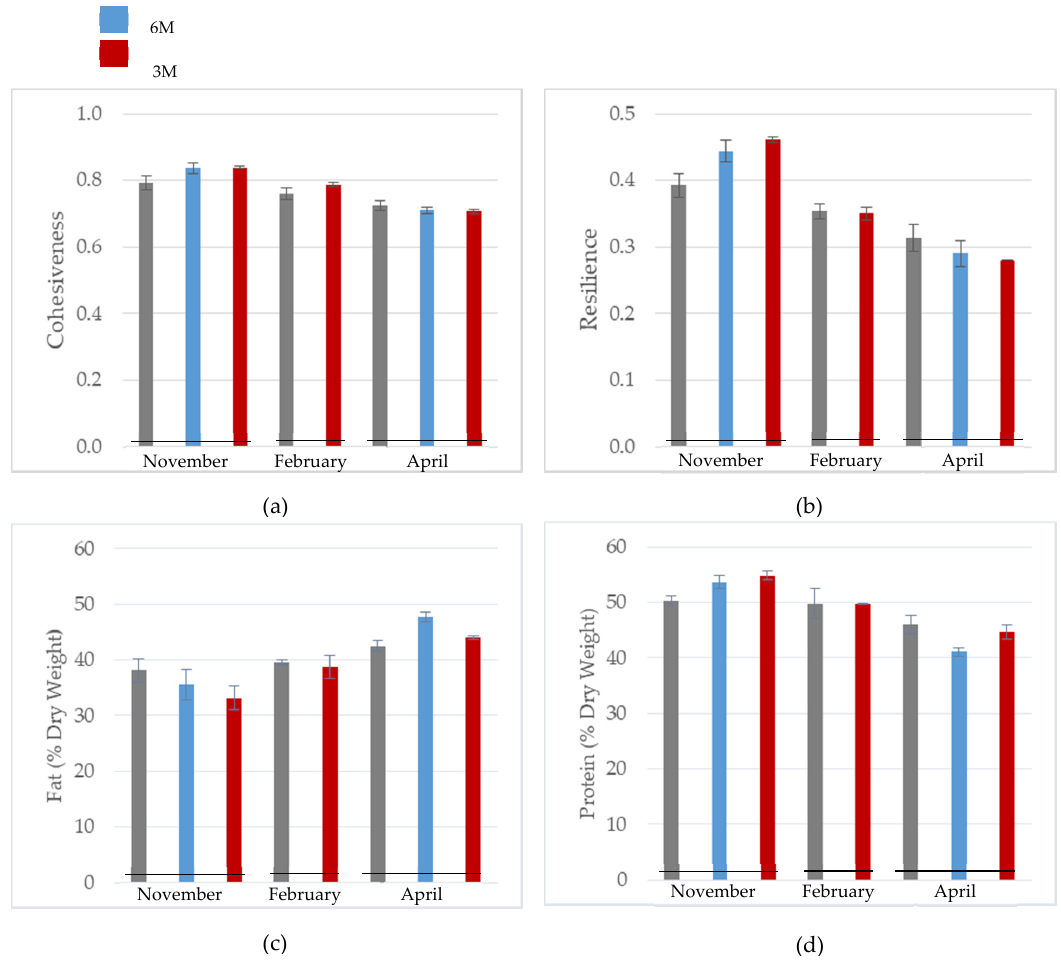
Figure 1. Variation of physical and chemical parameters: ( a ) cohesiveness, ( b ) resilience, ( c ) fat and ( d ) protein in PDO SE cheese according to cardoon type during the flock lactation stage.